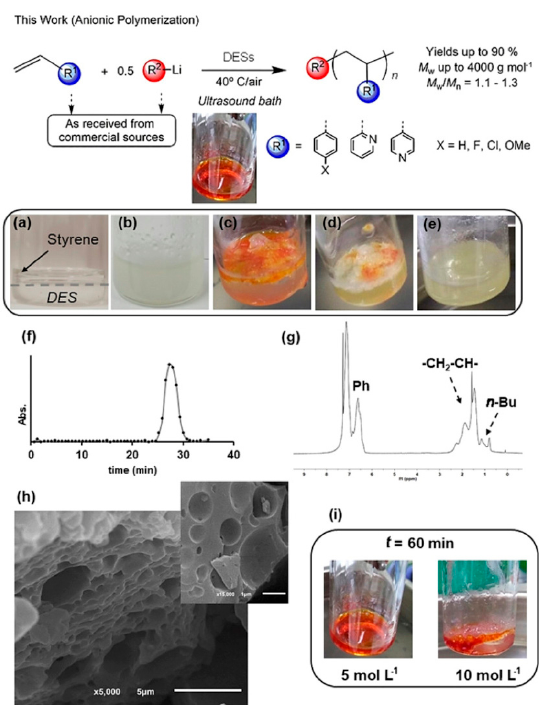
Figure 5. Anionic polymerization of various p -substituted styrenes, 2-vinylpyridine and 4-vi- nylpyridine in a 2:1 glycerol:ChCl DES open to the air. Figures ( a )–( e ): photographs of the reaction ([styrene] = 1 M) before and after ultrasonication, 5, 10 and 20 min after addition of n -BuLi. Figures ( f ) and ( g ): Size exclusion chromatography (SEC) trace and 1 H NMR spectra of polystyrene formed by this approach. Figure ( h ): SEM image of isolated polystyrene. Figure ( i ): photograph of the re- action after 60 min polymerization at different styrene concentrations. Adapted with permission from [80], Copyright 2019 John Wiley and Sons.